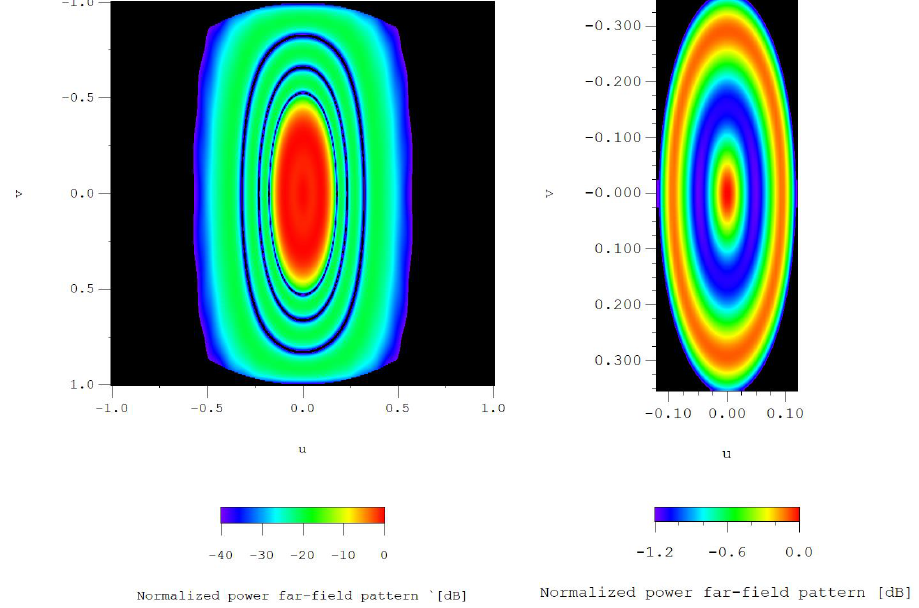
Figure 15. Interpolated image of the 3D normalized far-field pattern for the case of the layout of Figure 14 (extension of the Tseng and Cheng method for 𝑝 = 1 and 𝑞 = 10 ): 3-D Normalized radiation pattern cut at −40.0 dB ( left ). Detail of the shaped region: far-field radiation levels over −1.20 dB ( right ).